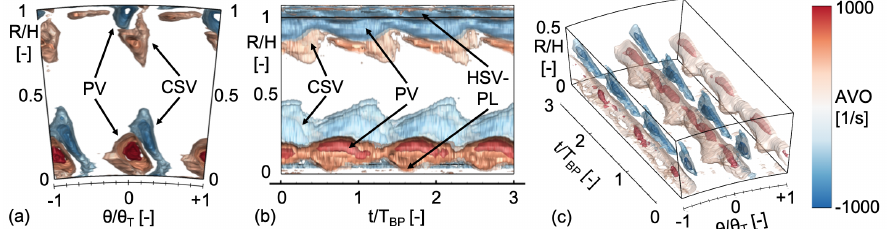
Figure 33. Temporal AVO flow field evolution (iso-contours) in the T106 RUB exit flow field ( ∆ x = 0.16 C) with the time as the third dimension, Sr = 1.33, φ = 0.97. View of radial-circumferential plane ( a ), of radial-axial plane ( b ) and of the lower half of the secondary flow system in a three-dimensional depiction ( c ), see